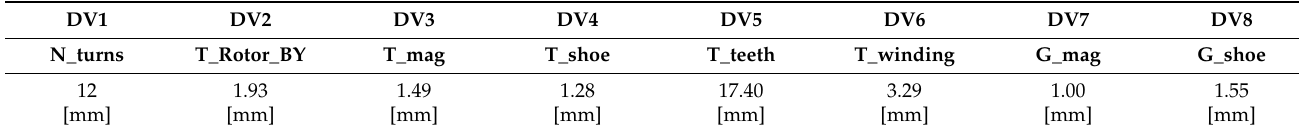
Table 6. Final Model Design Variable of Optimization Results.